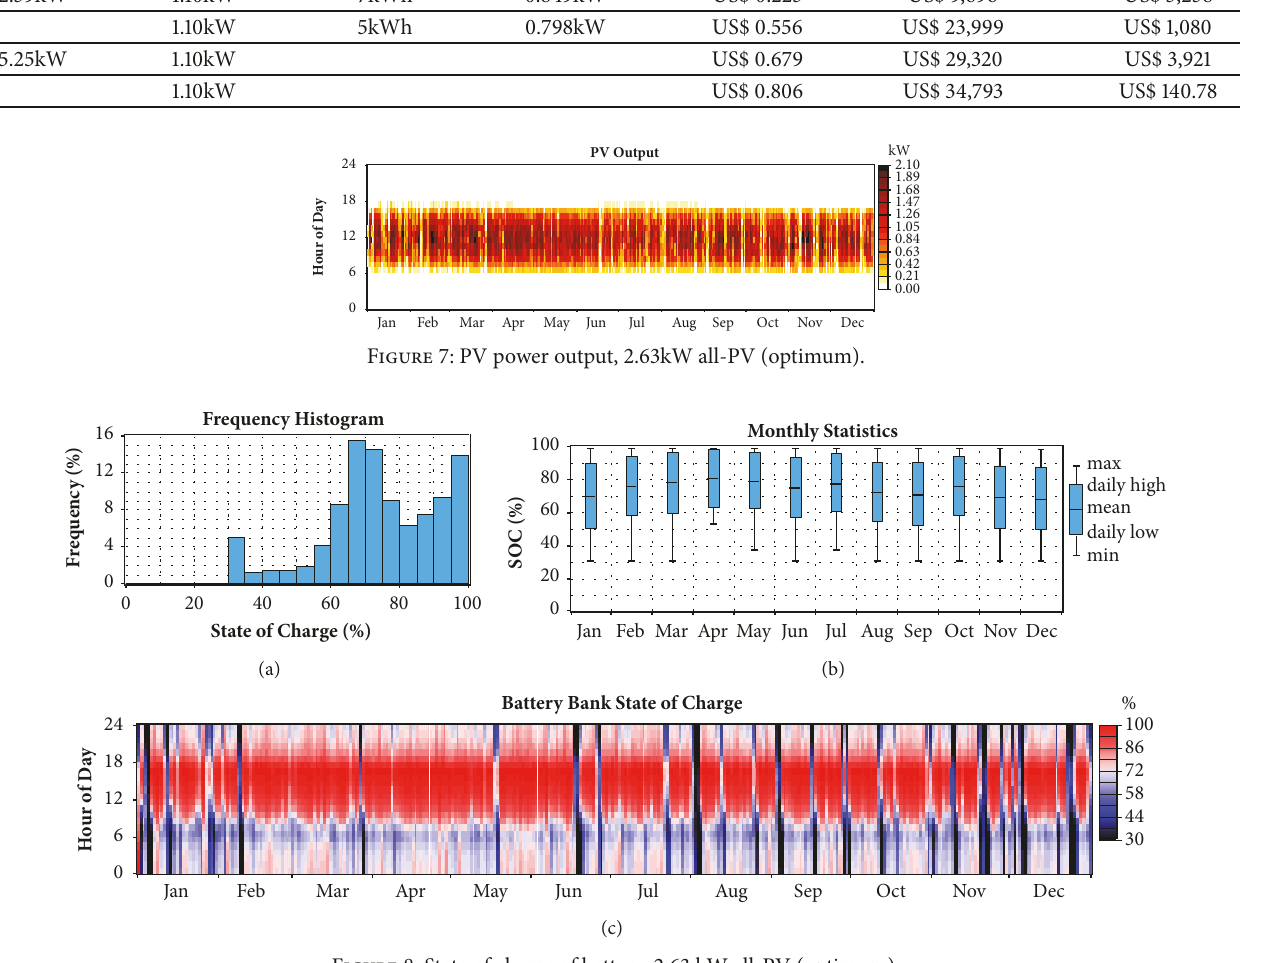
Figure 8: State of charge of battery, 2.63 kW all-PV (optimum).